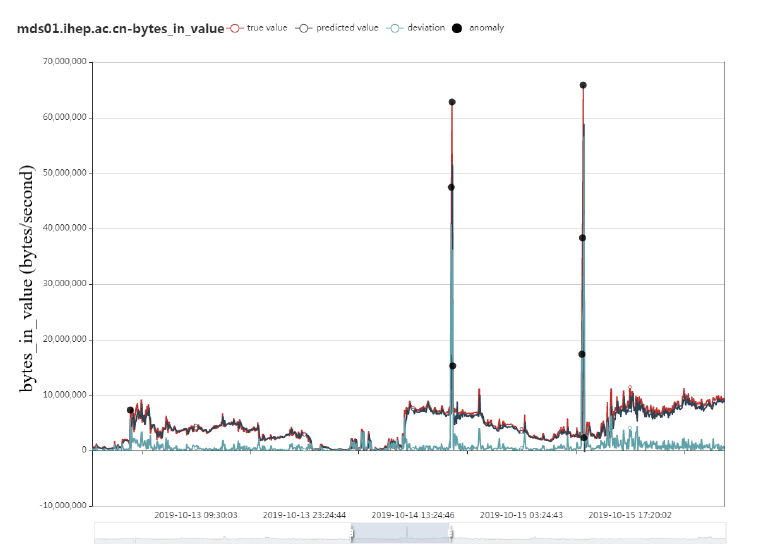
Figure 4. Result of temporal anomaly detection method 2. The red line shows true bytes_in_value of mds01.ihep.ac.cn. The dark blue line shows the predicted value of bytes_in_value by LSTM. The light blue shows the deviation between true value and predicted value. The black points show the anomalies.